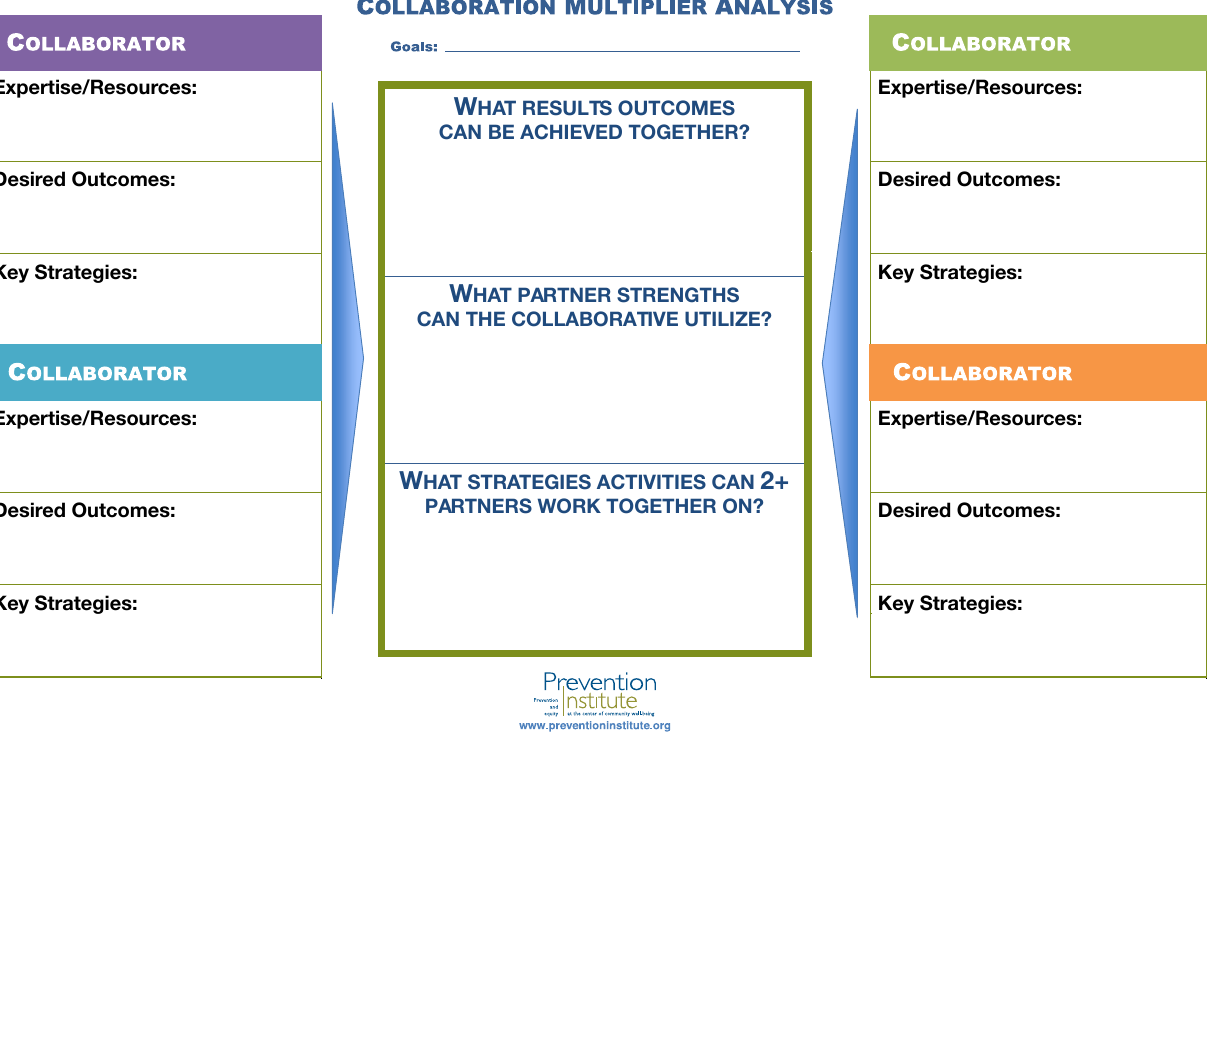
A GUIDE FOR STATE AND LOCAL GOVERNMENTS · 30